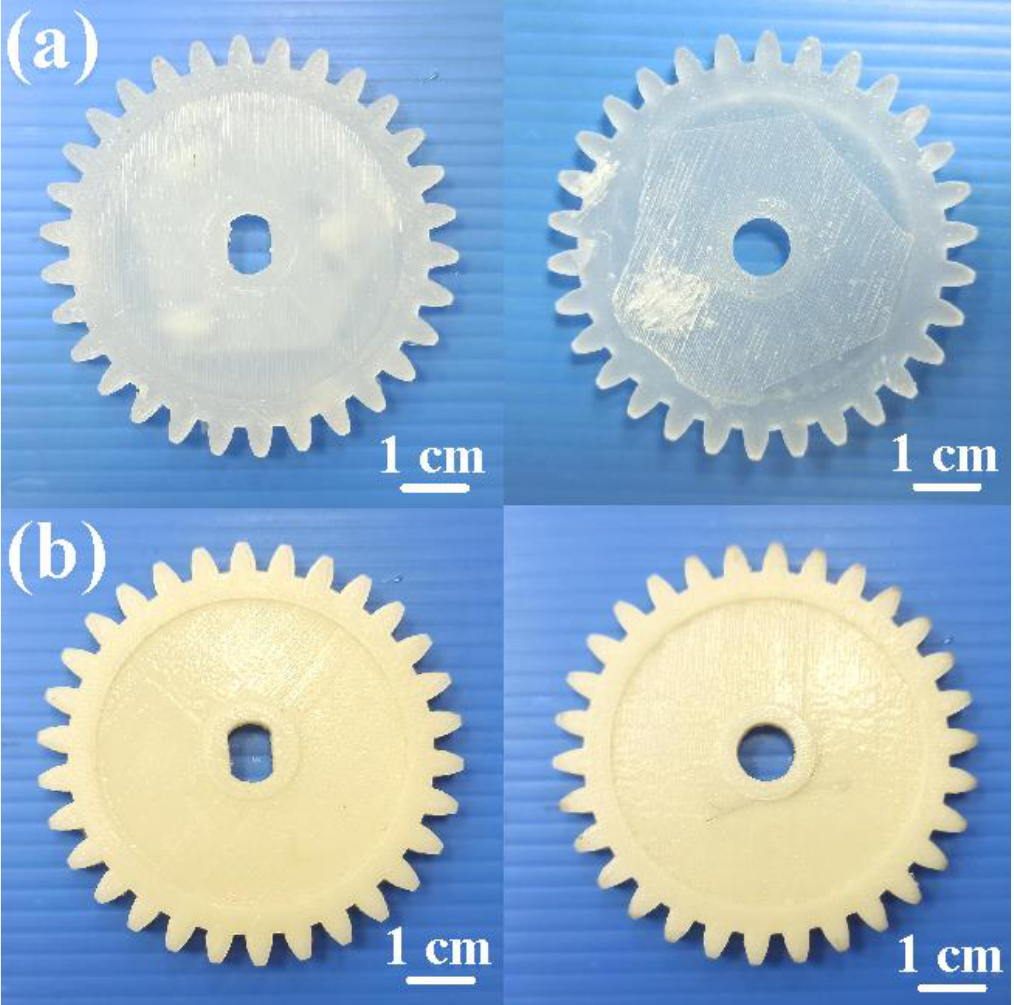
Figure 17. Spur gears fabricated by ( a ) epoxy and ( b ) polyurethane resins using DPVC technique. Driving gear ( left ) and passive gear ( right ).